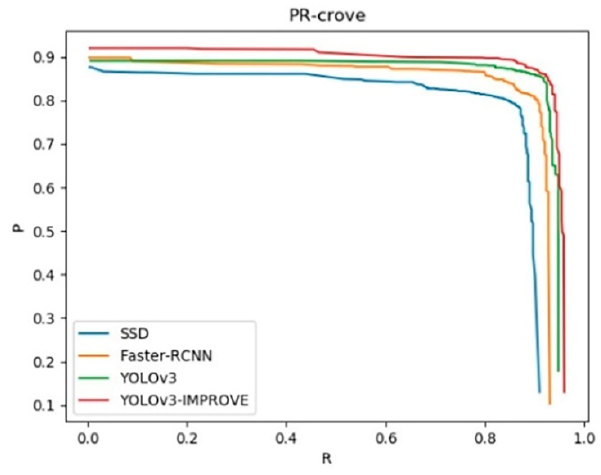
Figure 14. P-R curve for several models.